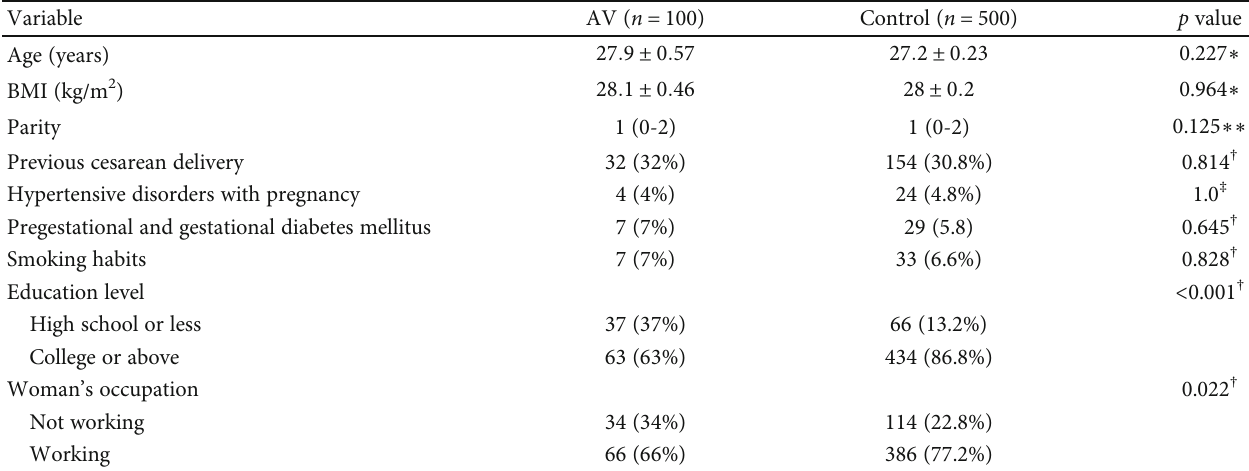
Table 1: Demographic and clinical characteristics.